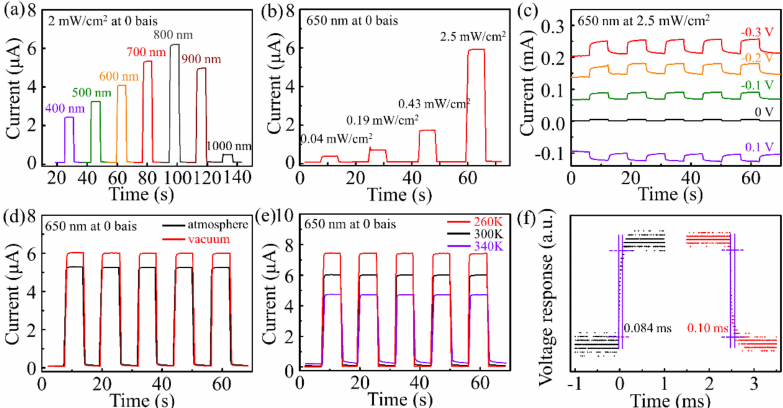
Figure 7. The detection performance of the Mo 2 C—Gr/Sb 2 S 0.42 Se 2.58 /TiO 2 /FTO photodetector under illumination from the Mo 2 C—Gr side. ( a ) The current-time curves of the photodetector under a 2 mW/cm 2 illumination with a wavelength of 400 nm to 1000 nm at 0 bias. ( b ) Self-powered photoresponse under an illumination of 650 nm light. ( c ) At various bias voltages, the photoresponse under a 2.5 mW/cm 2 illumination with 650 nm wavelength. ( d ) The current-time curves of the photodetector in atmosphere and vacuum under a 2 mW/cm 2 illumination of 650 nm wavelength light at 0 bias. ( e ) Photoresponse at various temperatures. ( f ) The voltage response and recovery time of the photodetector.